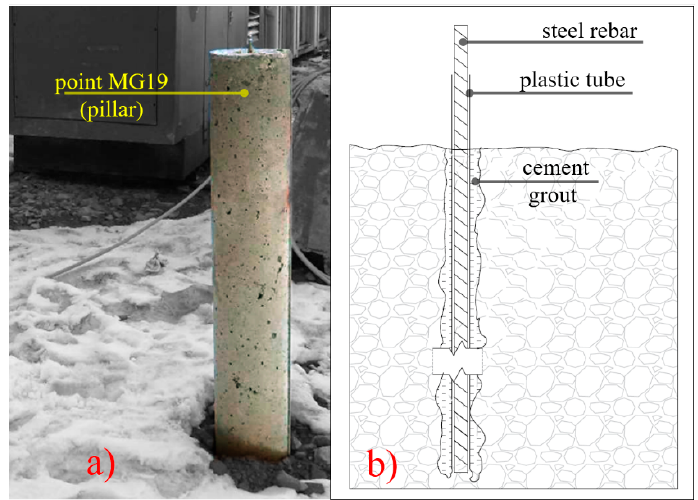
Figure 2. ( a ) Concrete pillar point MG19; ( b ) point stabilization with a combination of steel rebar, plastic tube and cement grout.